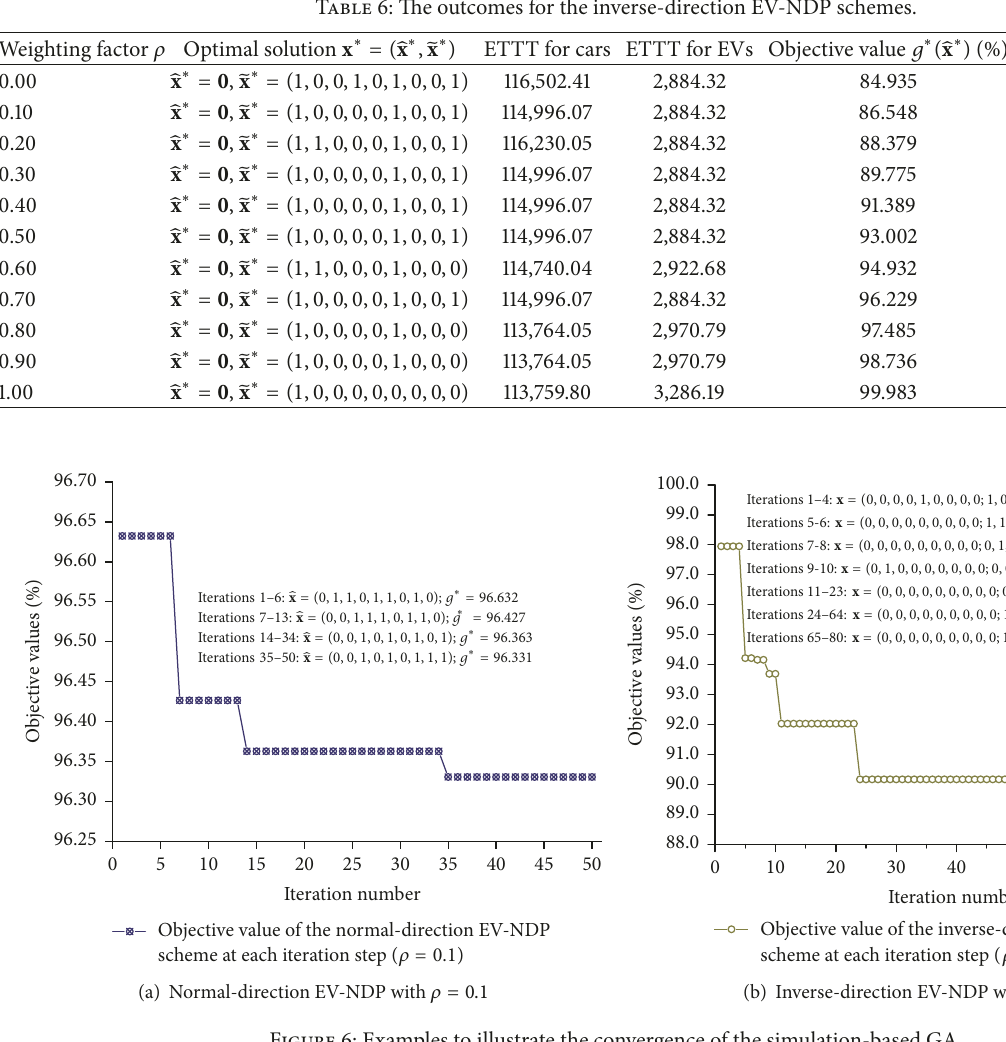
Figure 6: Examples to illustrate the convergence of the simulation-based